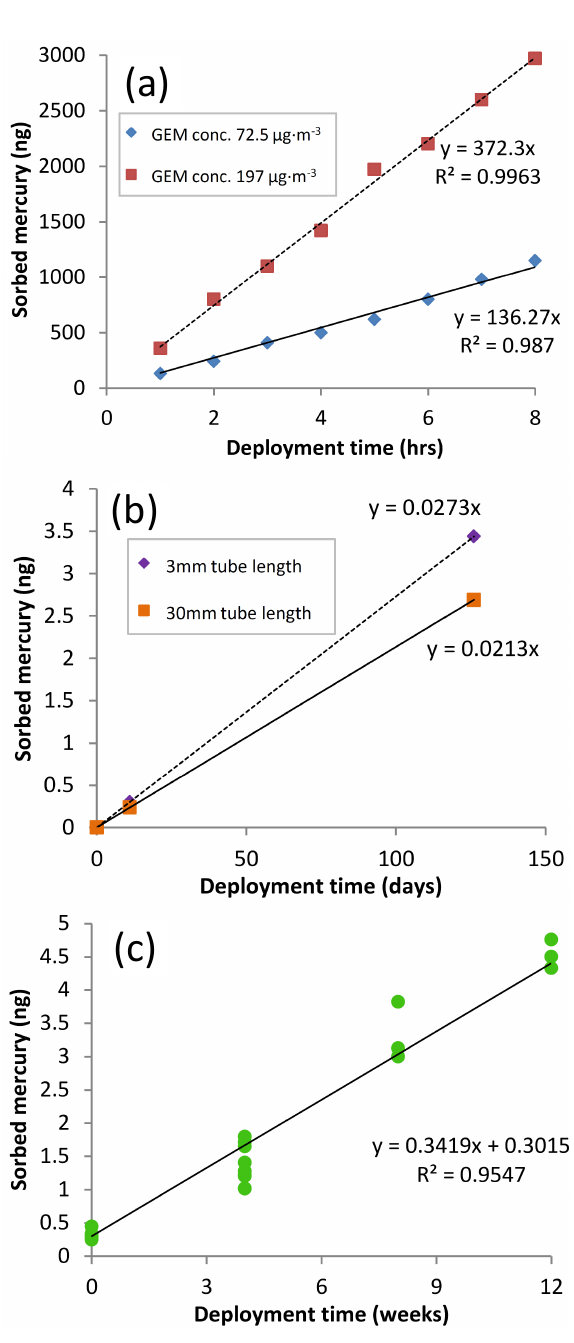
Figure 5. Passive sampling uptake curves plotting deployment time against the mass of sampled Hg. (a) Data from Mniszek et al. (2001). (b) Data from Nishikawa et al. (1999); each data point represents the mean of five replicates. (c) Data from Brumbaugh et al. (2000); y intercept represents the mean Hg level of sorbent blanks. Graph (a) and graph (b) data were obtained using PlotDigi- tizer, Free Software,